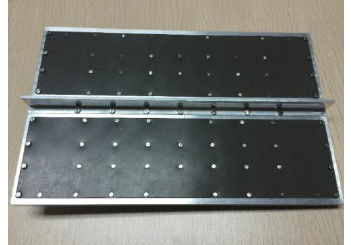
Figure 4 The ground control